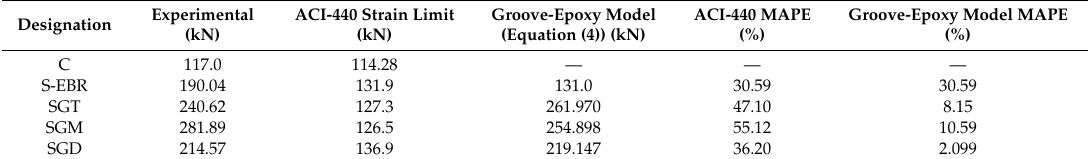
Table 6. Measured and predicted loads for RC beam strengthened with CFRP sheets on groove-epoxy.